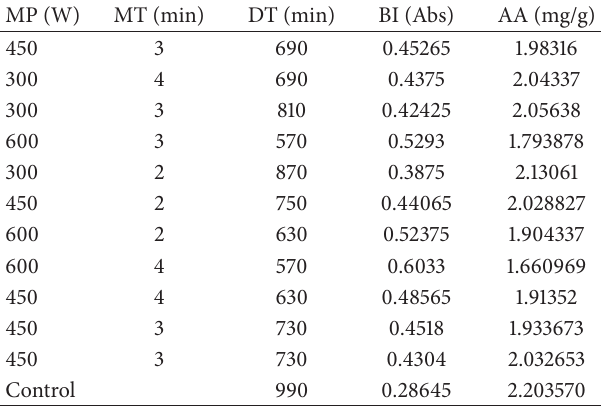
Table 2: Three-level factorial design for two factors and results of DT, BI, and